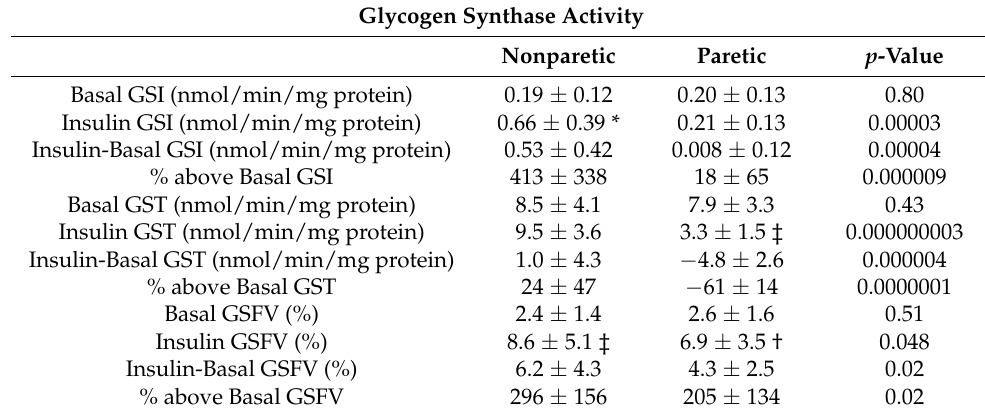
Table 3. Glycogen synthase activity in stroke survivors ( n = 23) before (basal) and during (insulin) a euglycemic clamp.